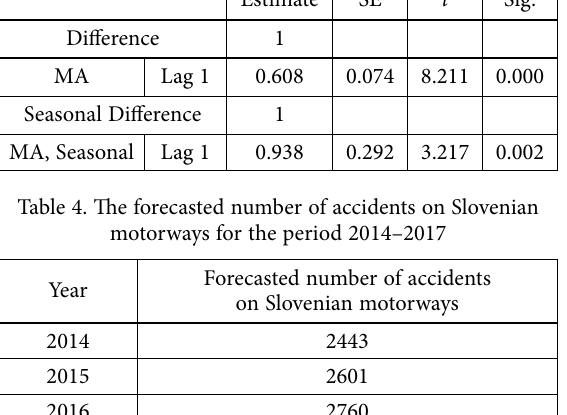
Table 3. SARIMA model parameters for the number of traffic accidents on Slovenian motorways Estimate SE t Sig.